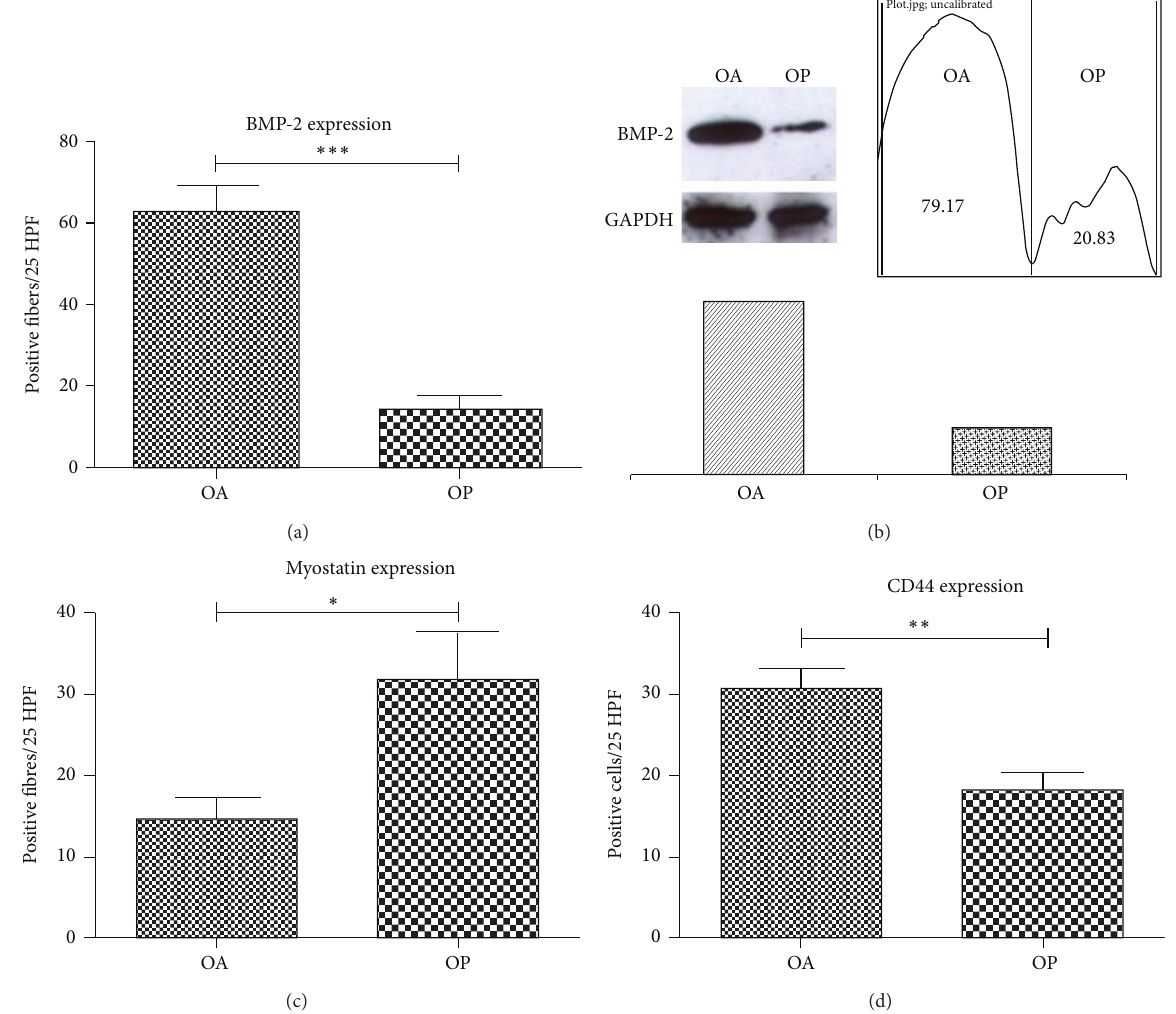
Figure 2: Protein expression analysis. Immunostaining for BMP-2, myostatin, and CD44 was evaluated by counting the number of positive fibers/cells on 25-high power field (HPF), whereas western blot for BMP-2 was evaluated by lines densitometry. (a) Notably, we found that OA muscle biopsies showed a significantly higher number of BMP-2-positive fibers ( 293.0 ± 35.4 ) as compared with muscle of OP patients ( 162.1±33.7 ) ( 𝑝 < 0.0001 ). (b) Western blot lines show a higher expression of BMP-2 in OA patients compared to OP group. (c) The number of myostatin positive fibers in OP patients was significantly higher compared to OA group ( 𝑝 < 0.0200 ). (d) CD44 expression shows a significantly different rate of CD44 positive cells in OA group as compared with OP ( 𝑝 < 0.0020